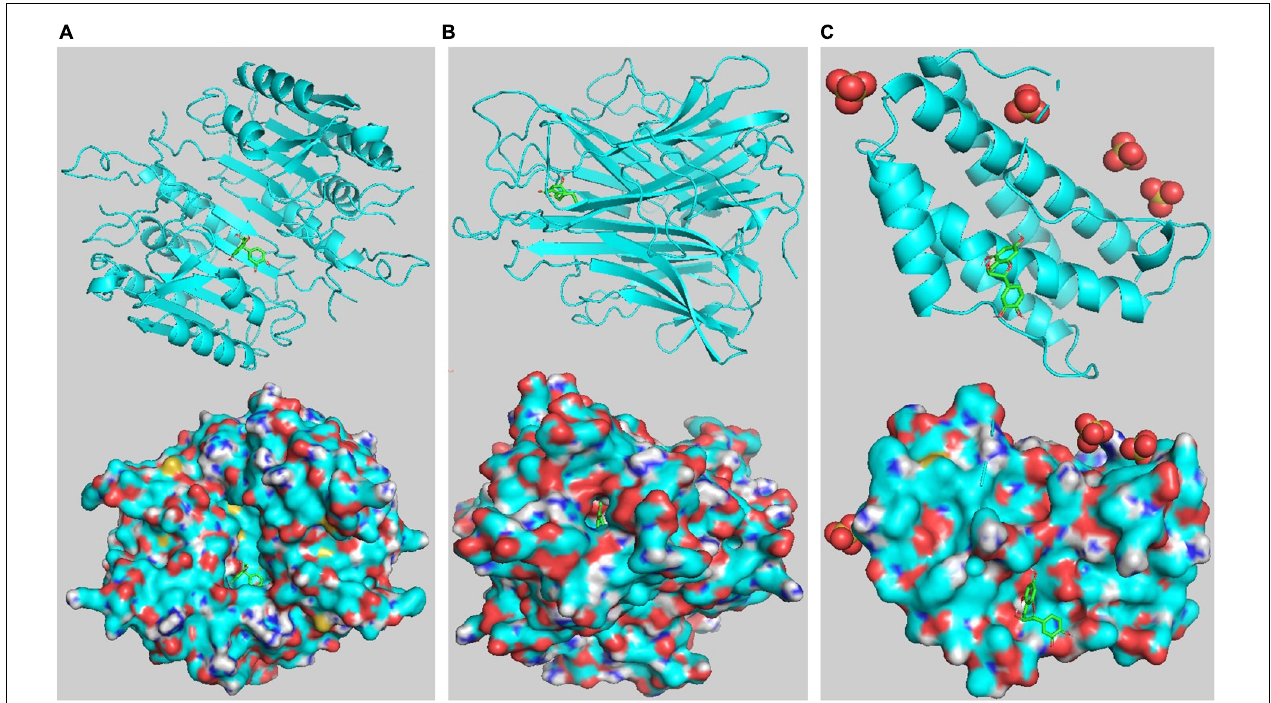
FIGURE 10 | Target-compound interactions with the three highest molecular docking affinities. (A) CASP3- catechin. (B) TNF-senkyunolide I. (C) IL6- catechin. On the top shows the 3D structure of ligands and receptors, at the bottom shows the surface of the receptor and 3D structure of the ligands.